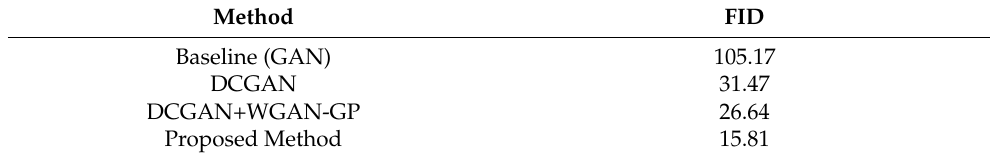
Table 2. Comparison average Fréchet inception distance (FID) of Generative Models [6].